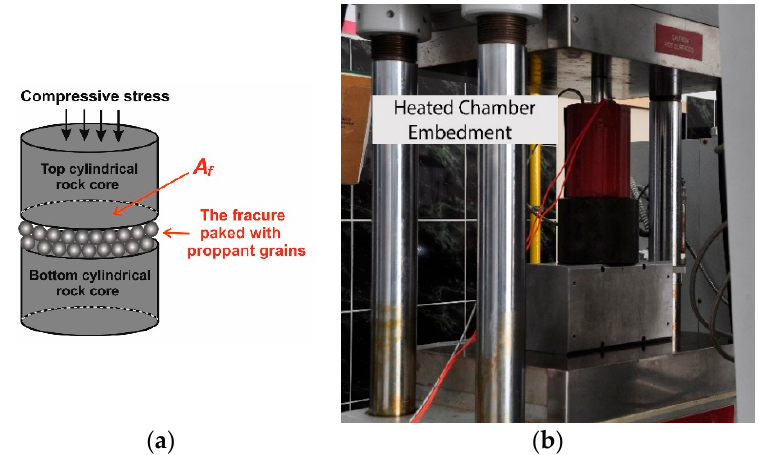
Figure 6. Test unit: ( a ) Arrangement of cores and proppant into the chamber; ( b ) Hydraulic press with heating chamber for the simulation of the embedment phenomenon.